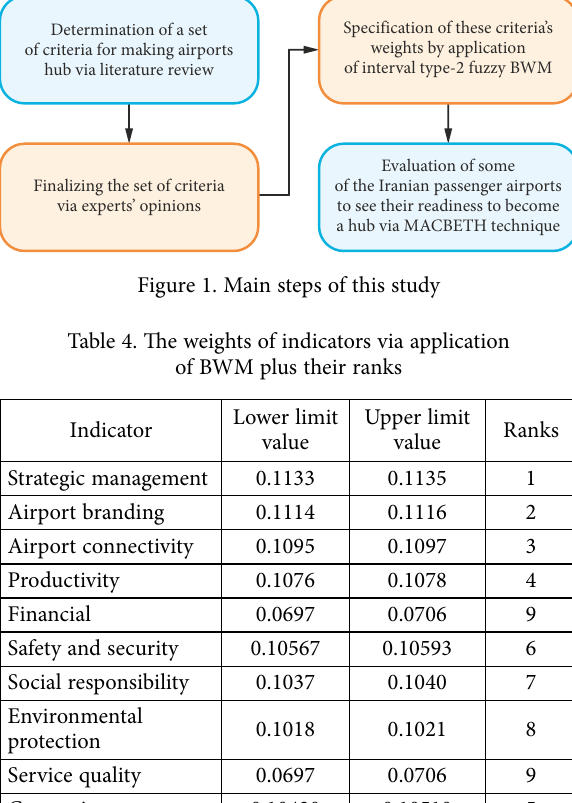
Specification of these criteria’s weights by application